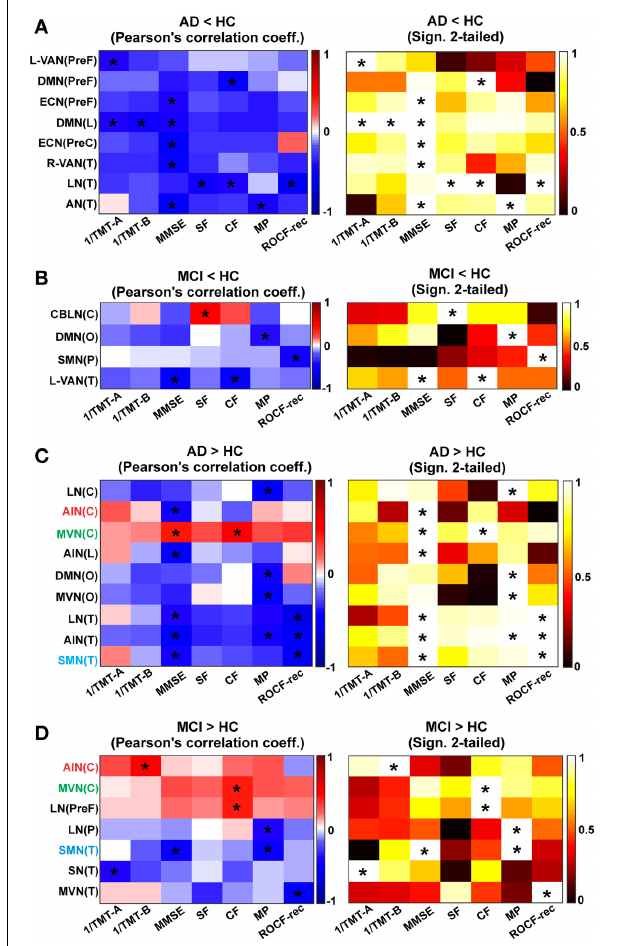
FIGURE 8 | Correlation between r gFC changes and clinical and neuropsychological tests. Results are reported for each contrast (A) AD < HC, (B) MCI < HC, (C) AD > HC and (D) MCI > HC. Correlation matrixes (left) and the corresponding statistical significance of correlations (right) between clinical and neuropsychological tests (1/TMT-A, 1/TMT-B, MMSE, MP, CF, SF, ROCF-copy, and ROCF-rec) and r gFC areas: cerebellum (C), prefrontal (PreF), limbic (L), occipital (O), parietal (P), precentral (PreC), and temporal (T). Correlation and anti-correlation are reported on different color scales. Correlations that satisfied a statistical threshold of p < 0 . 01 are marked with a star ( ∗ ). The statistical significance (matrices on the right) of each Pearson’s correlation coefficient (matrices on the left, with the positive correlations in red scale and the negative ones on blue scale) is represented as 1– p